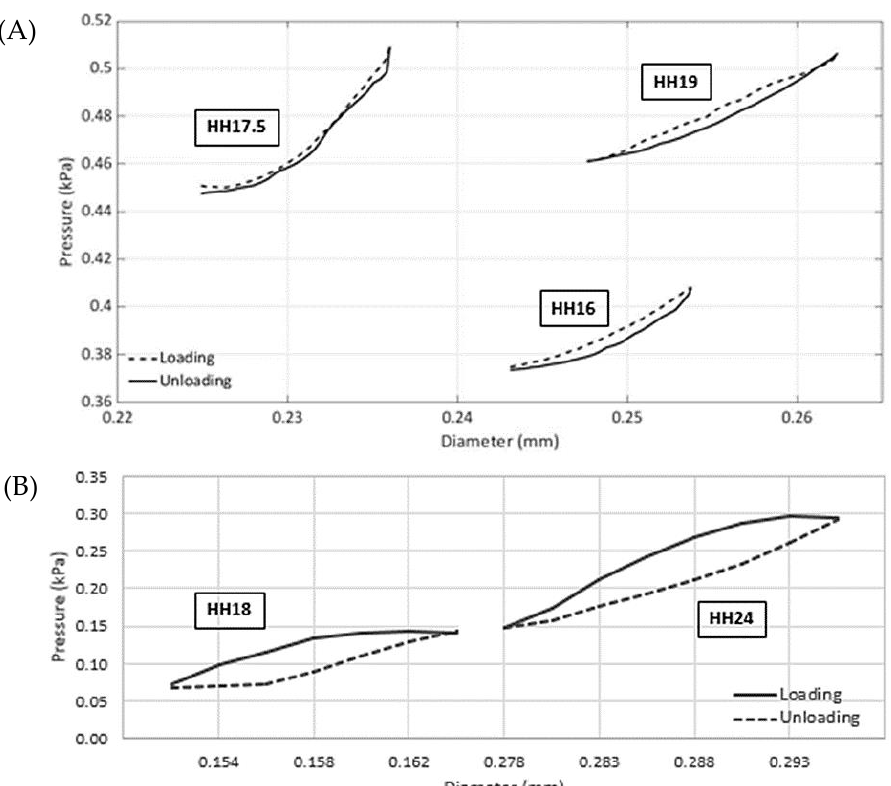
Figure 3. Representative pressure vs. lumen diameter loops of chick embryonic arteries acquired in vivo. ( A ). The vitelline arteries under loading and unloading conditions over the cardiac cycle. The data were collected for eight embryos (one representative sample shown) at three consequent stages of HH16, HH17.5, and HH19. ( B ). Right IVth aortic arch loading and unloading data over the cardiac cycle. The data were collected for five embryos (one sample shown) at two consequent stages of HH18 and HH24. Other sample data are available in the Supplementary Materials, and statistics are provided in Table 3. Data were acquired simultaneously using OCT and the servo-null pressure system described in Section 2.2. Table 3. Estimated Fung’s strain energy function parameters (Equation (1)) for loading and unloading at HH16, HH17.5, and HH19 for the vitelline artery vessels and for the IVth aortic arch at HH18 and HH24 are tabulated. Sample numbers ( n ) are indicated for each artery type. Vitelline Artery ( n = 5) Aortic Arch ( n =